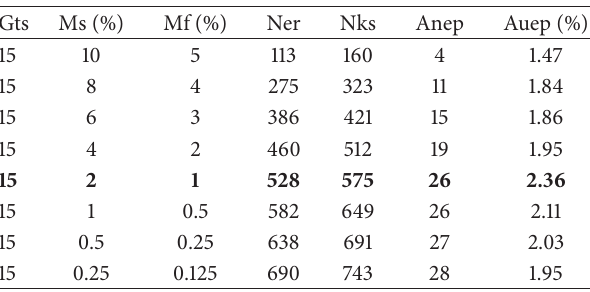
Table 6: Data records of the test in human-computer mode with experiential patterns.